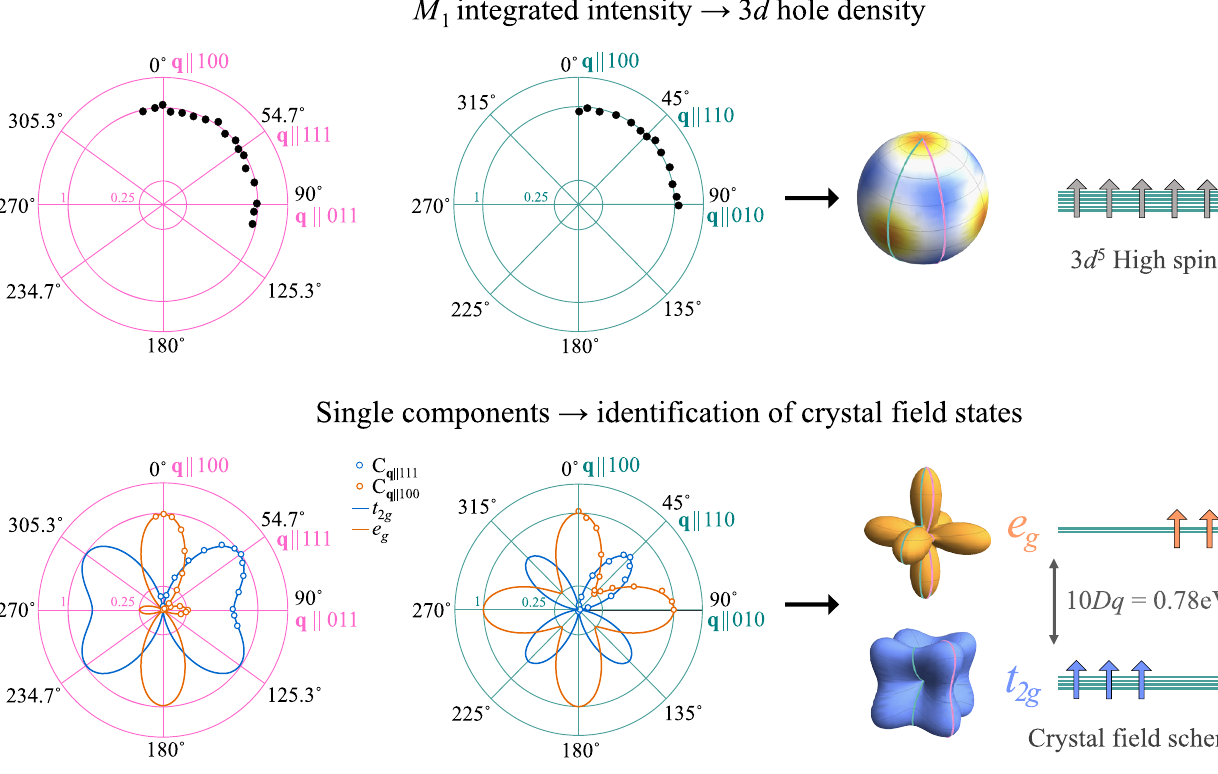
FIG. 3. Top: Polar plot of the integrated intensity of the Mn M 1 in the ½ 100 (cid:2) → ½ 111 (cid:2) → ½ 011 (cid:2) plane (far left, magenta) and in the ½ 100 (cid:2) → ½ 110 (cid:2) → ½ 010 (cid:2) plane (middle left, dark cyan), together with the circular-shaped projections of the spherical three-dimensional hole density (middle right) of the Mn high-spin 3 d 5 configuration (far right). Bottom: The intensity of the q k [100] (orange) and q k [111] (blue) components follow the angular dependence of the e splitting is about 10 Dq ¼ 0 . 78